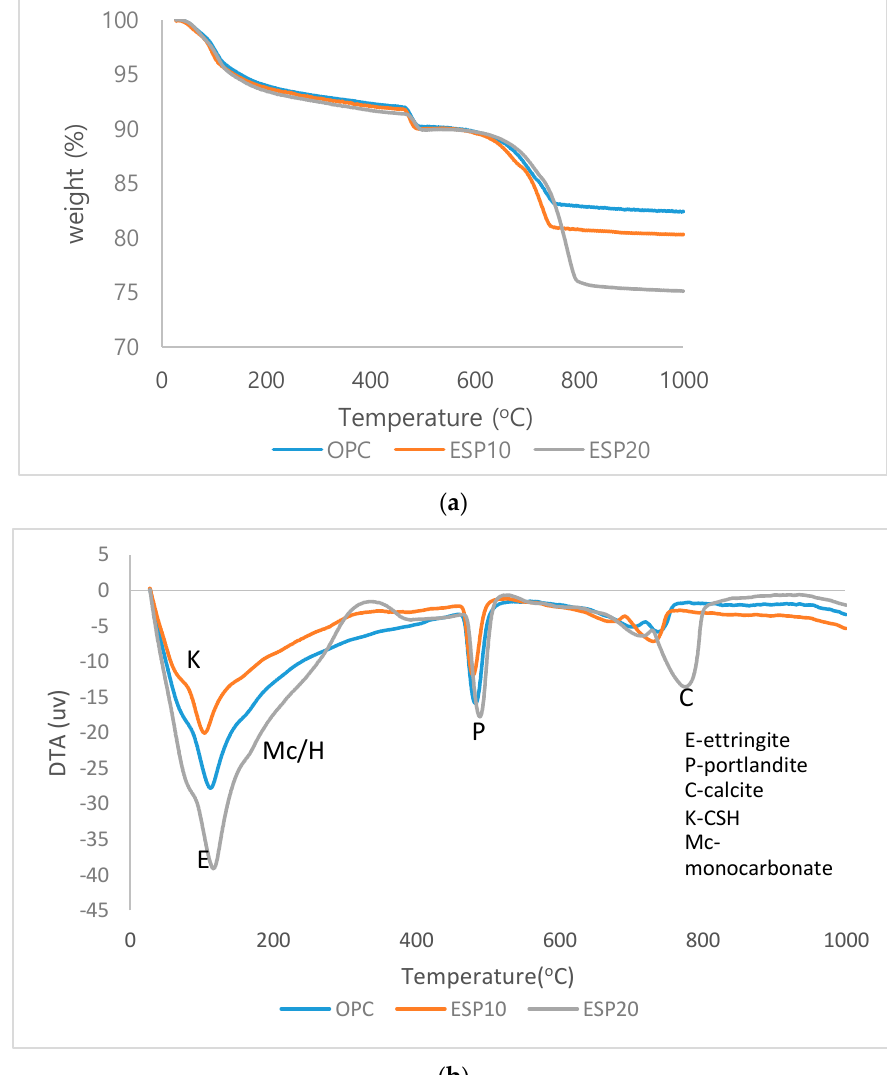
Figure 8. ( a ) TGA result of 1-day cement paste; ( b ) DTA result of 1-day cement paste.